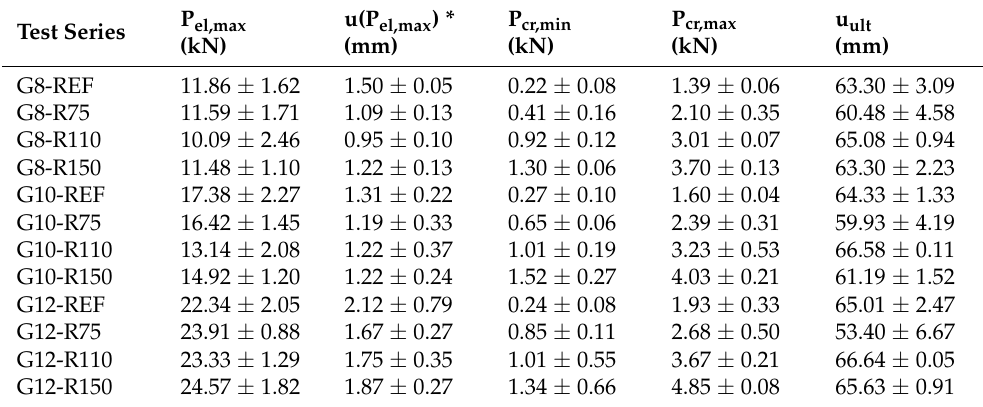
Table 2. Results of the experimental